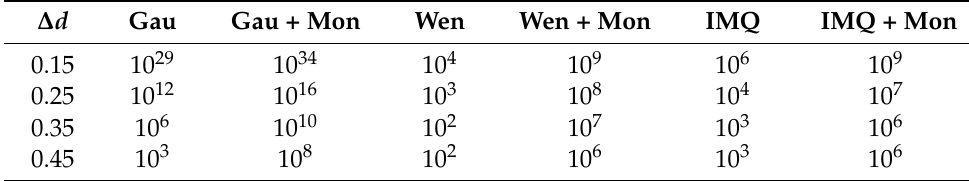
Table 2. Order of condition numbers of the linear systems for different interpolation schemes and varying point distance ( R 0 = 1.5mm, c G = 2.7, c I = 0.2). Here, the expert driver routines of [29] are